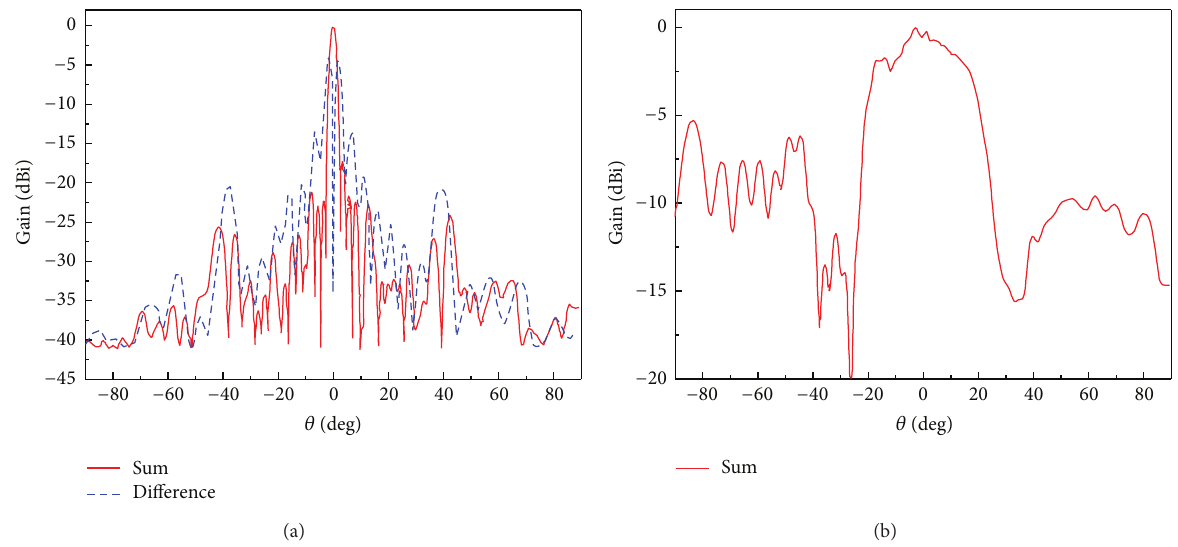
Figure 3: Measured normalized (a) E-plane sum and difference radiation patterns and (b) H-plane sum radiation pattern at